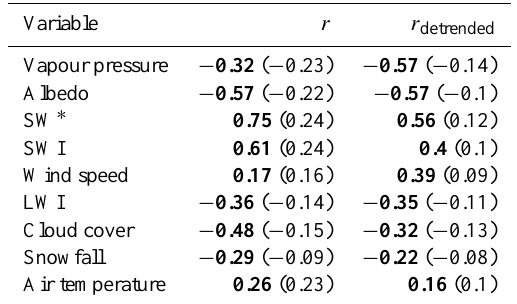
Table 5. Correlation coefficient ( r ) between daily sublimation (mmw.e.day − 1 ) and principal meteorological variables recorded at the AWS. r detrended is the correlation coefficient using detrended data, i.e. after removing the seasonal cycle for each variable ex- cept the cloud cover and snowfall, which are bounded by zero. The 5% significance level determined from the permutation test is in- dicated in parenthesis and significant correlations are indicated in bold. Variables are ordered from the largest to smallest r detrended absolute value.